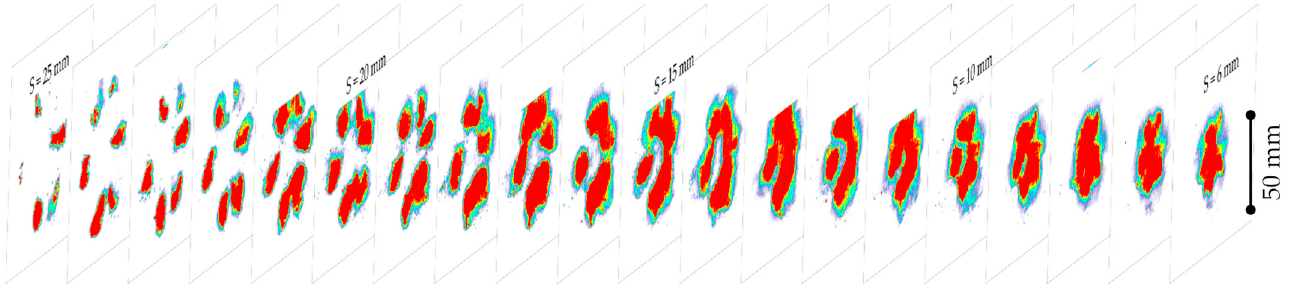
Figure 9. Sequence of images of the fuel jet in cross ‐ section; the view includes the full sequence of tests from 6 to 25 mm from the tip of the atomizer.